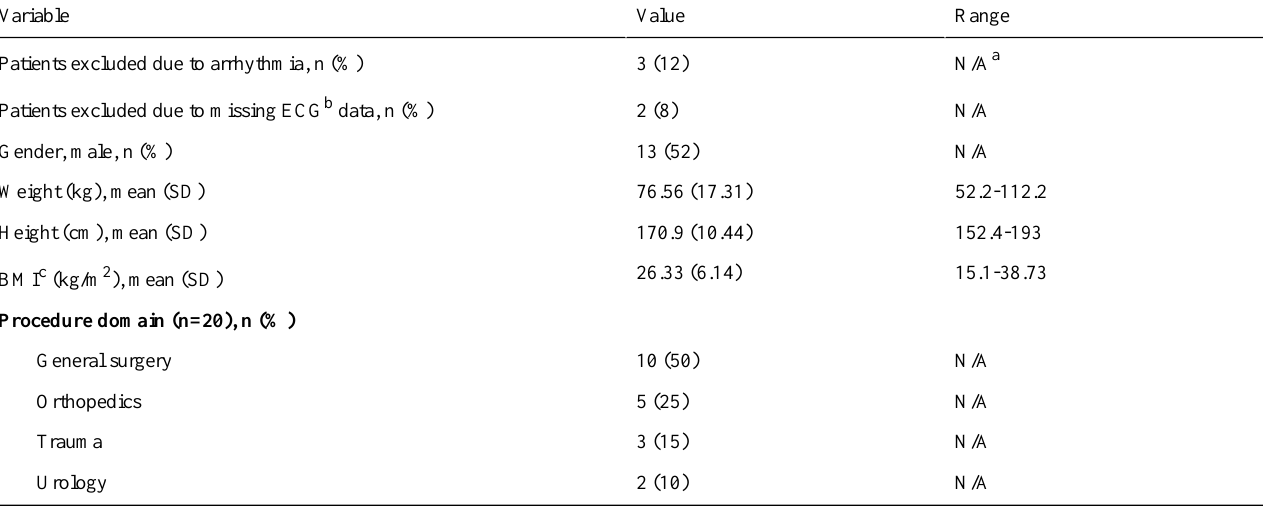
Table 5. Patient demographic characteristics